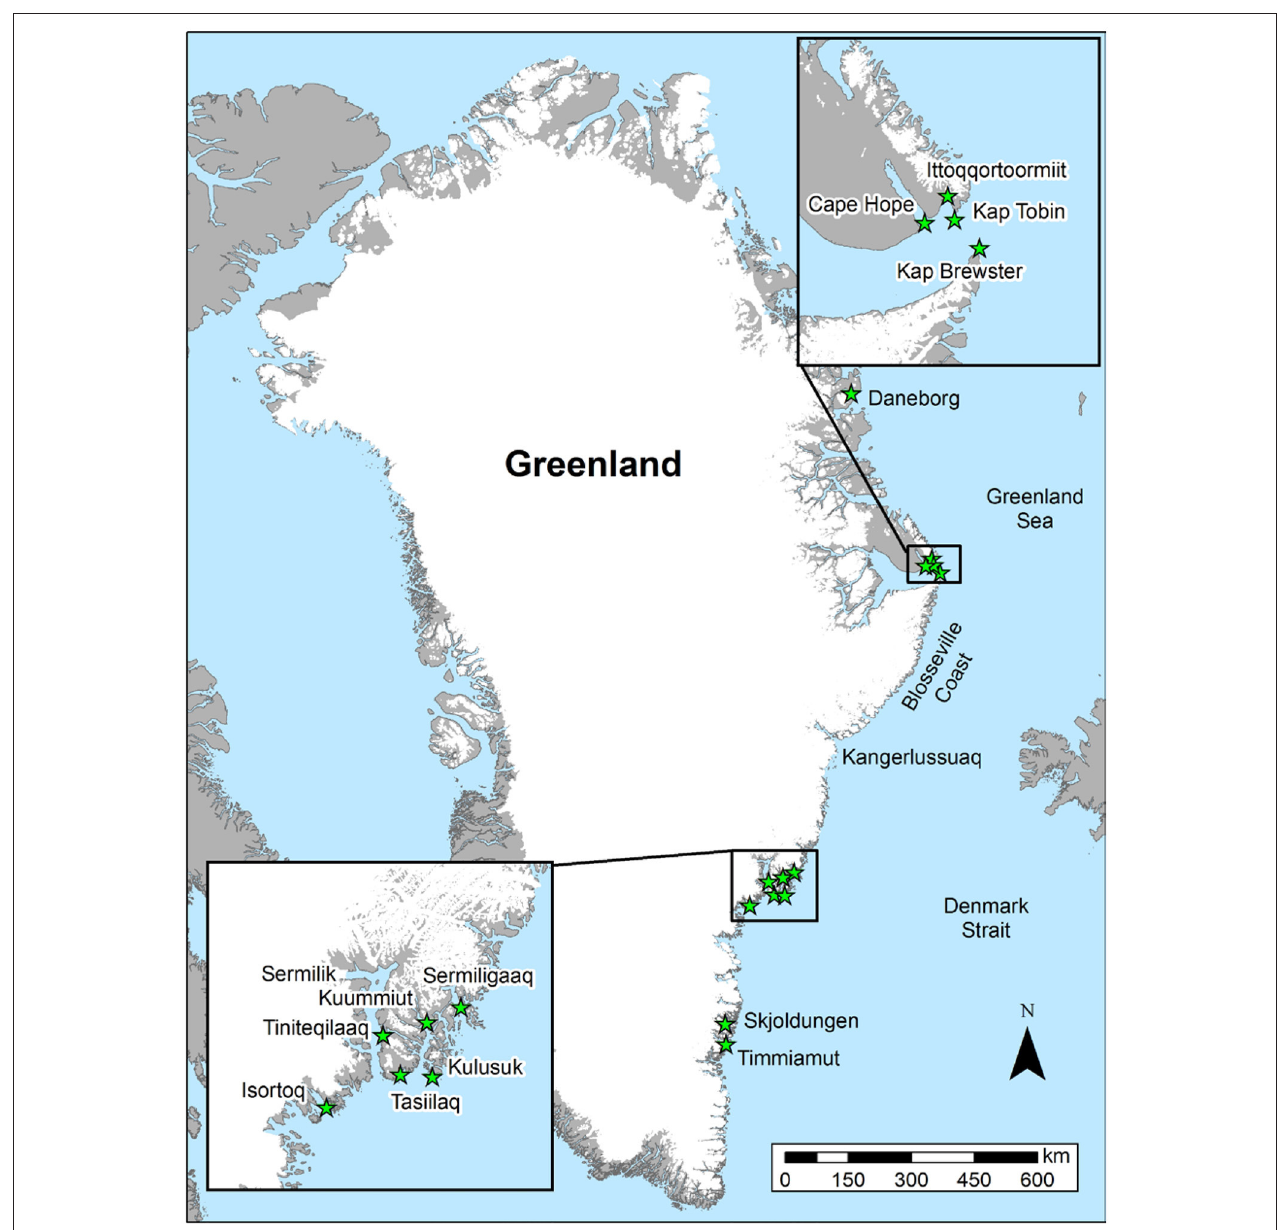
FIGURE 1 | Map of the study area in East Greenland, including settlements and major localities discussed in the